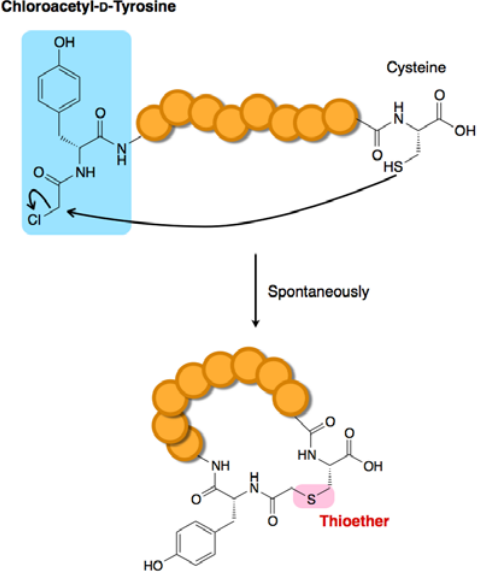
Figure 4. Macrocyclization by post-translational thioether-ring closure [36,45]. A chloroacetyl-amino acid incorporated at the N -terminus using the FIT system spontaneously reacts with a downstream Cys to generate a macrocyclic thioether